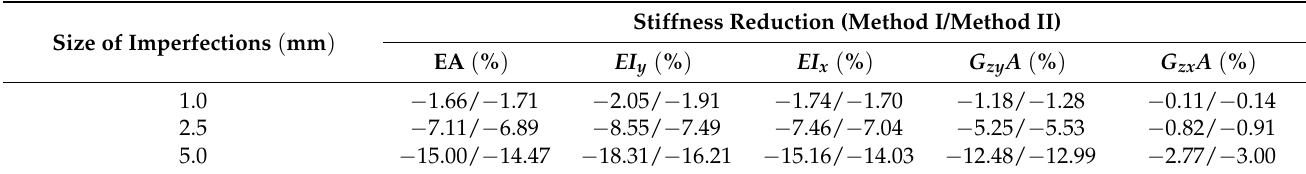
Figure 12. Buckling due to shearing for case (ii), for a depth of 100 mm: ( a ) mode 1; ( b ) plot of the stiffness reduction of G zy A , depending on the size of imperfections. Table 8. Stiffness reduction of the Z profile with an elongation of 100 mm due to shearing for case (ii), depending on the size of